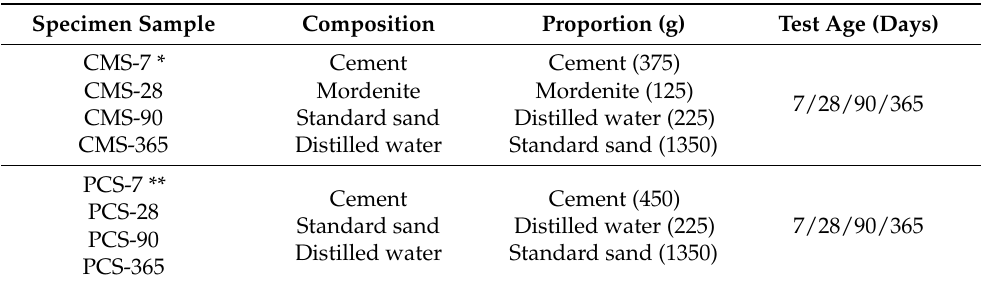
Table 1. Proportions of materials in CMM and PCM mortars and their test